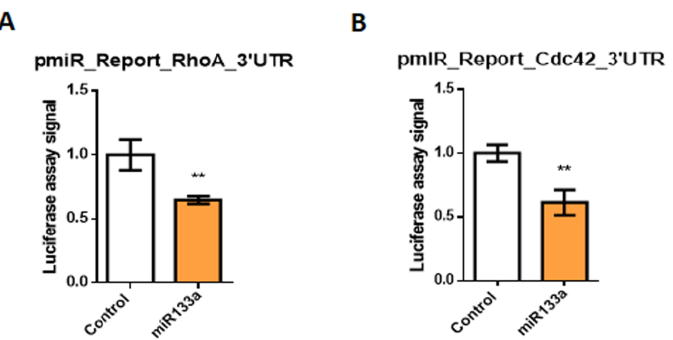
Figure 1. Representative data of RhoA ( A ) and Cdc42 ( B ) 3′UTR luciferase assays after premiR -133a overexpression in 3T3 fibroblasts. Luciferase activity was compared to non-transfected controls. Each luciferase assay was carried out in triplicate. Student’s t -test: ** p < 0.01.